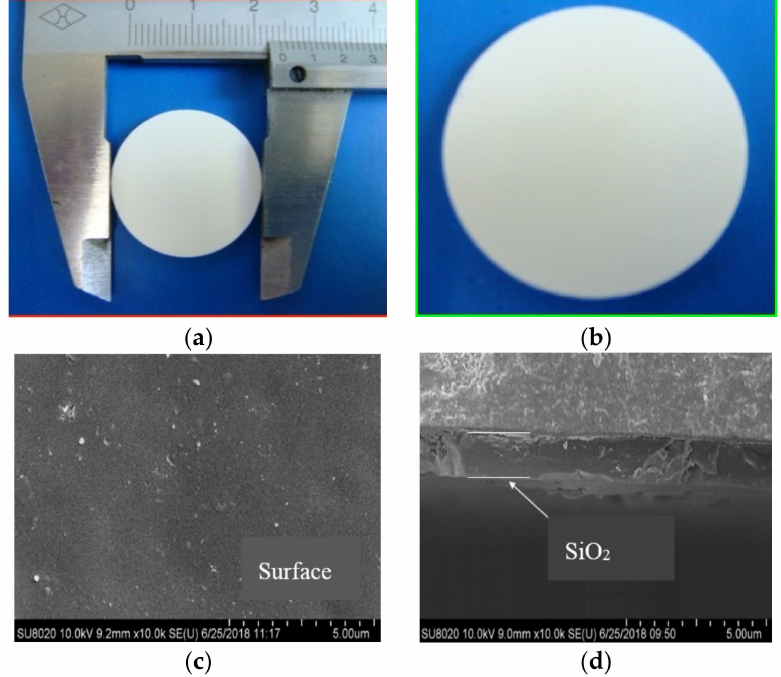
Figure 2. Digital photos of the samples: ( a ) α -Al 2 O 3 support, ( b ) post-grafted silica membrane and scanning electron microscope (SEM) images of the silica membranes: ( c ) surface, ( d )